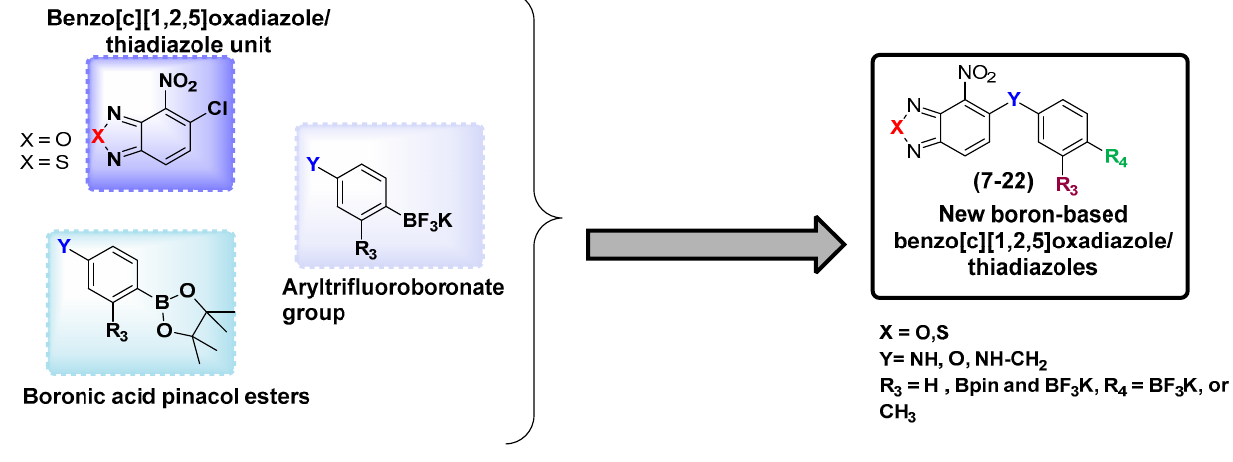
Figure 4. Design strategy.